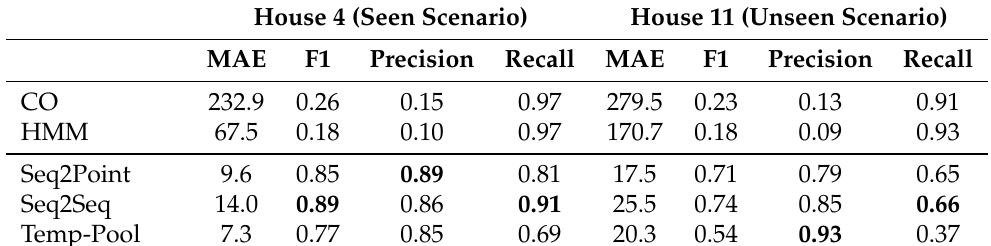
Table 6. The results of the disaggregation performance.